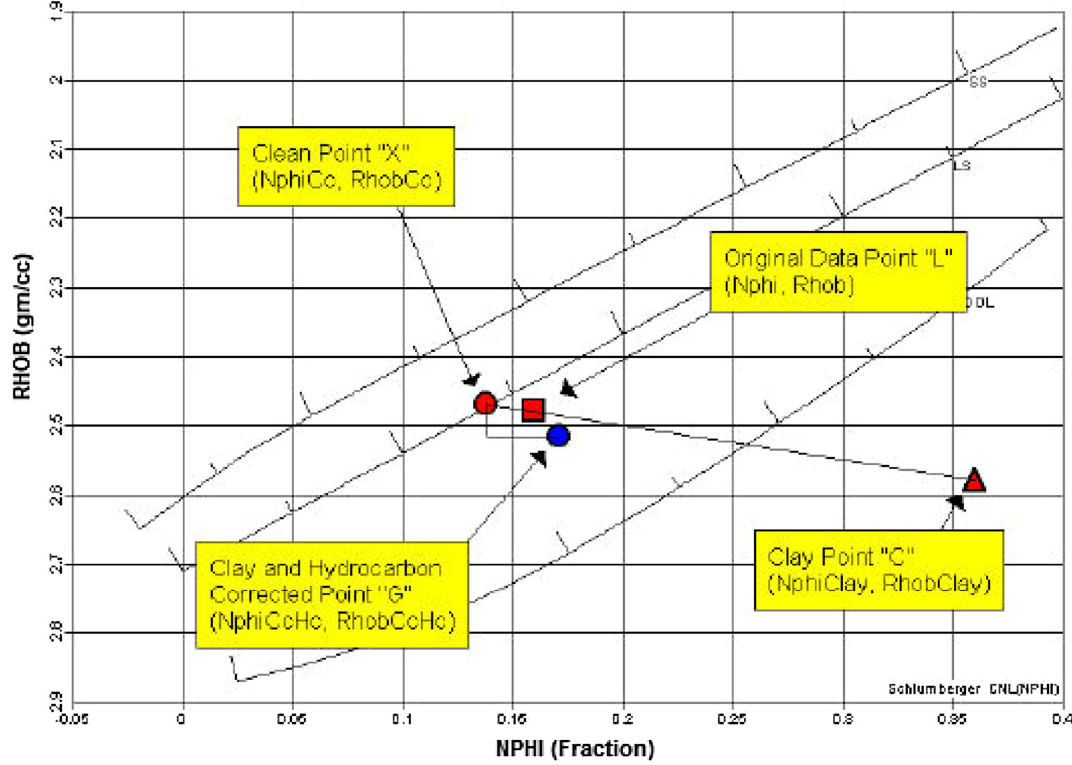
Fig. 13 Simple diagram of complex lithology neutron-density